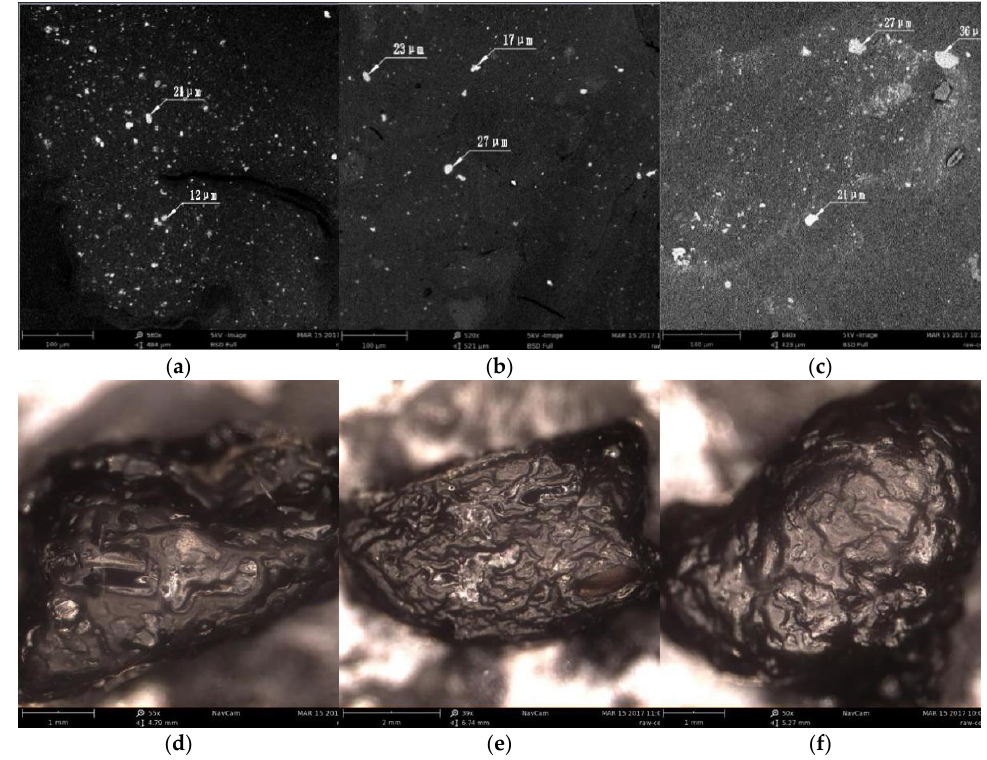
Figure 4. Scanning electron microscope images of asphalt modified with different dosages of rubber powder: ( a ) 25% rubber-powder content (560 times); ( b ) 30% rubber-powder content (520 times); ( c ) 35% rubber-powder content (640 times); ( d ) 25% rubber-powder content (55 times); ( e ) 30% rubber-powder content (39 times); ( f ) 35% rubber-powder content (50 times).